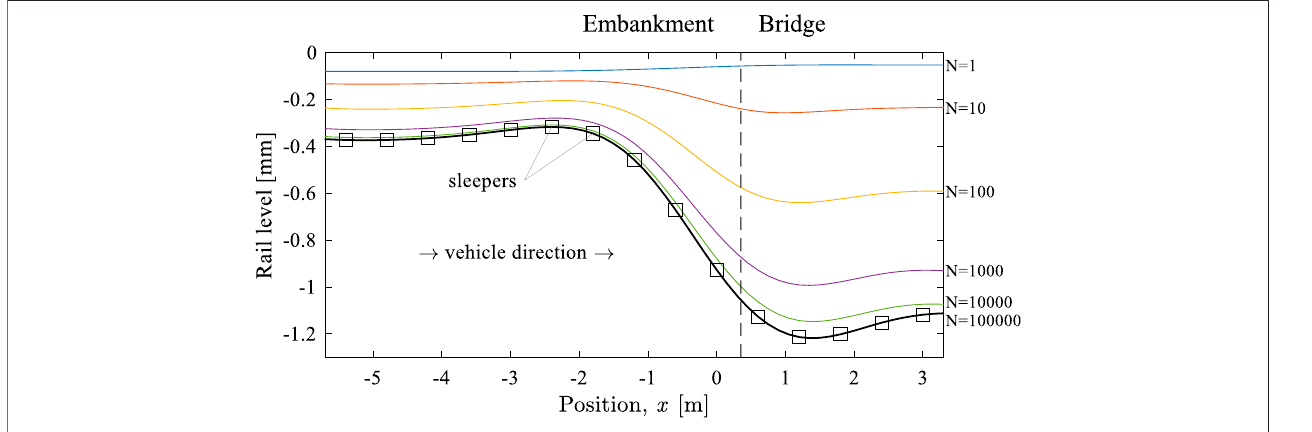
FIGURE 5 | Change in longitudinal rail level with the number of load cycles